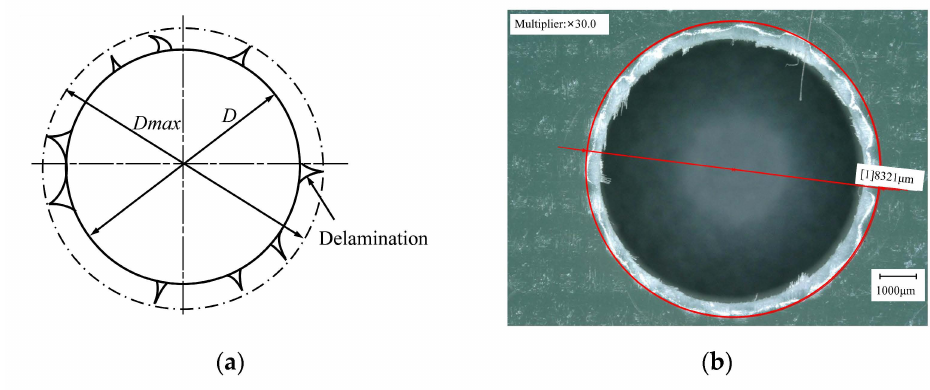
Figure 3. Diagram of F d . ( a ) Measurement diagram of F d . ( b ) Measurement by microscope.